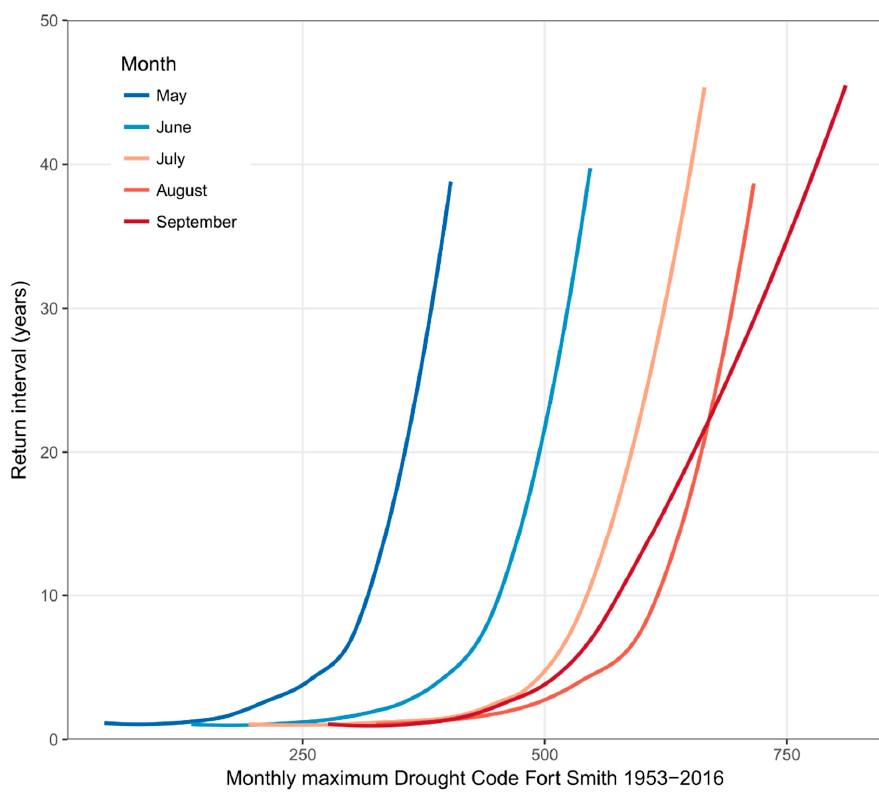
Figure A2. Historical distribution of maximum monthly Drought Code in the study area at Fort Smith, with unique distributions for each calendar month of the fire season. Annual return interval was calculated from the historical method using the Gumbel (1941) variant of the Generalized Extreme Value distribution and smoothed using a loess function for visual clarity.